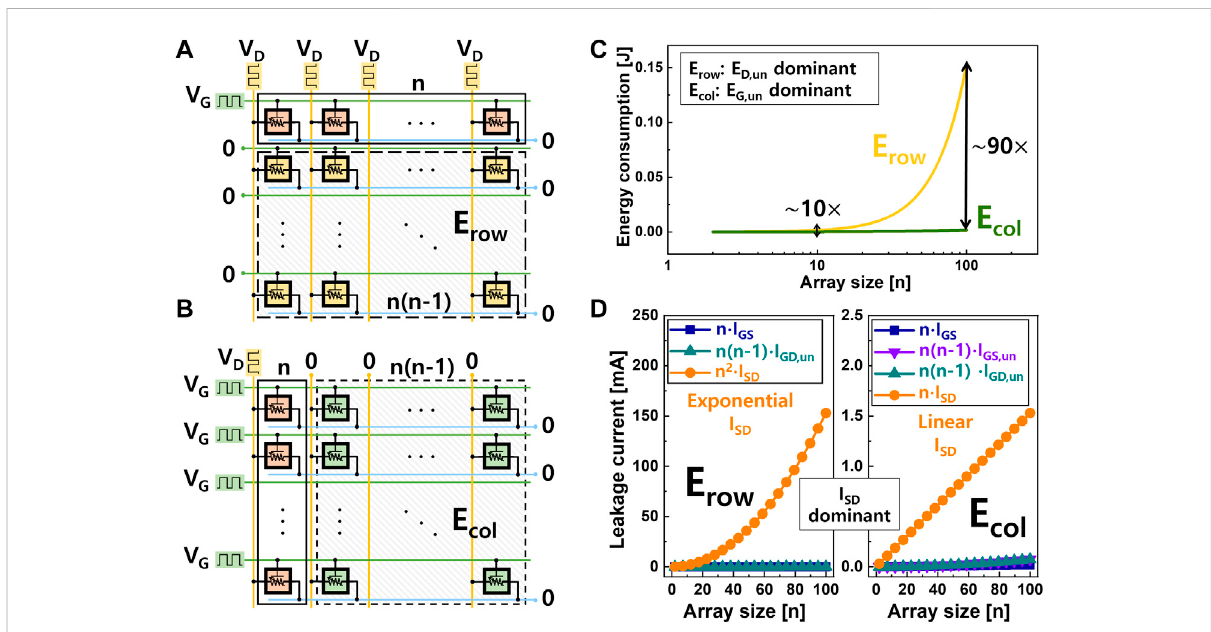
number of cells in a row-by-row fashion, G 1 was turned on. Simultaneously, an additional V D was needed to be addressed through the D 1 and D 2 lines (bottom of Figure 4B). As a result, E loss occurred due to the considerable I SD from the unselected cell areas. When a few cells were updated in a row or column in the array, the E difference depending on the scheme became negligible because the participation of lines that produced leakages was reduced. Consequently, it